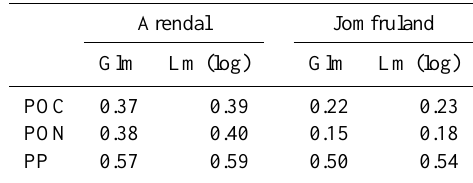
Table 3. Comparison of pseudo R 2 for GLM and R 2 for log-linear regression models of POC, PON and PP on Chl- a (se methods for description of